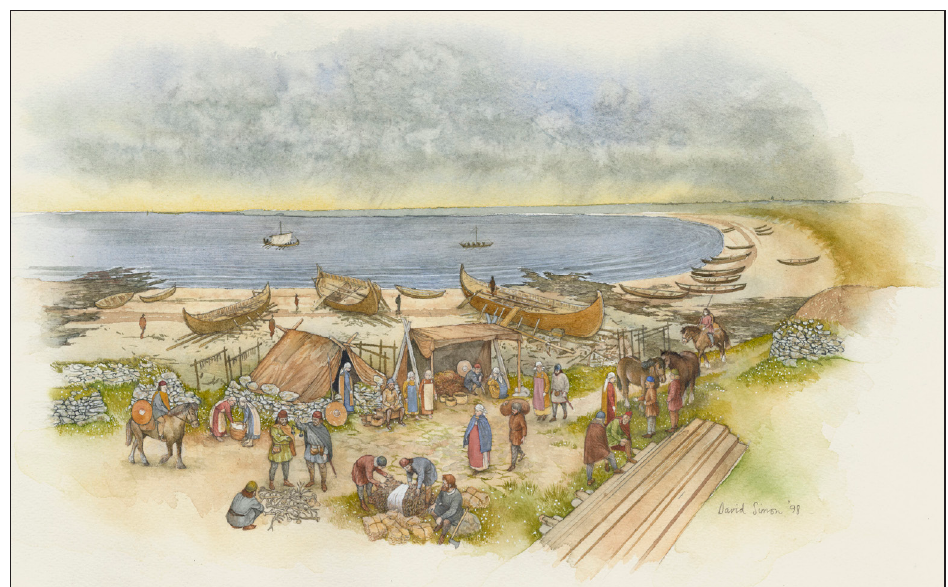
Figure 3: Reconstruction drawing of the possible market beach at Pierowall. © David